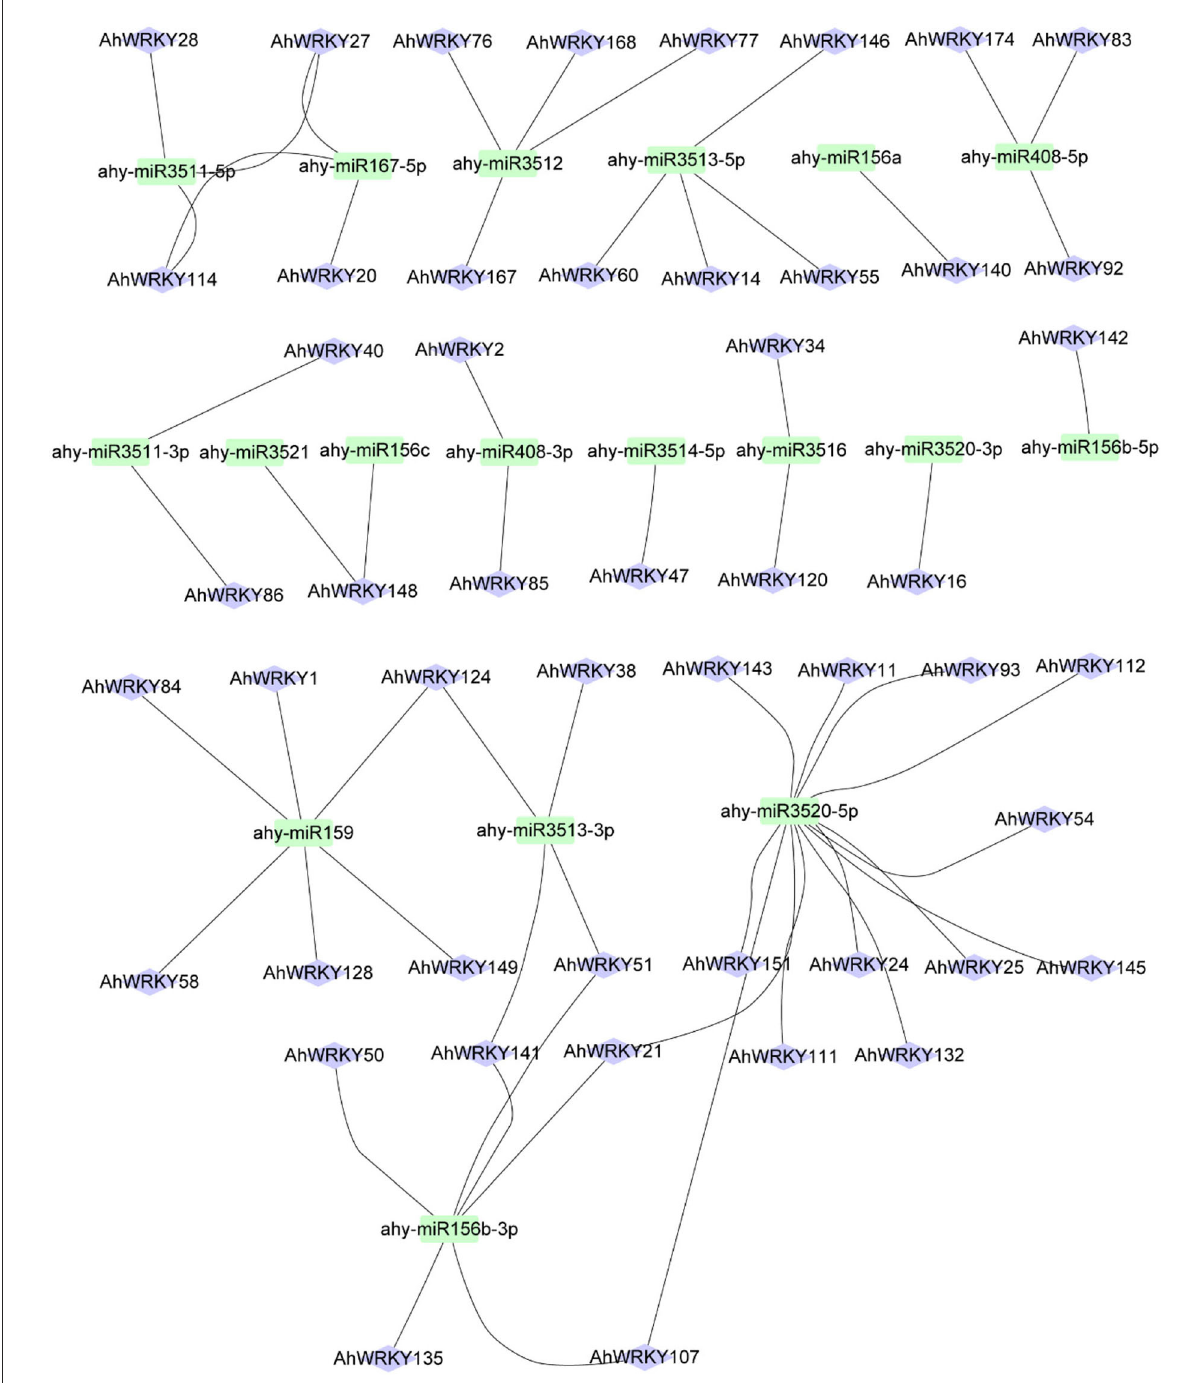
FIGURE8 Network figure of identified miRNA targeting AhWRKY genes. Green box colors correspond to miRNAs, and bluish ellipse shapes represent target WRKY genes.